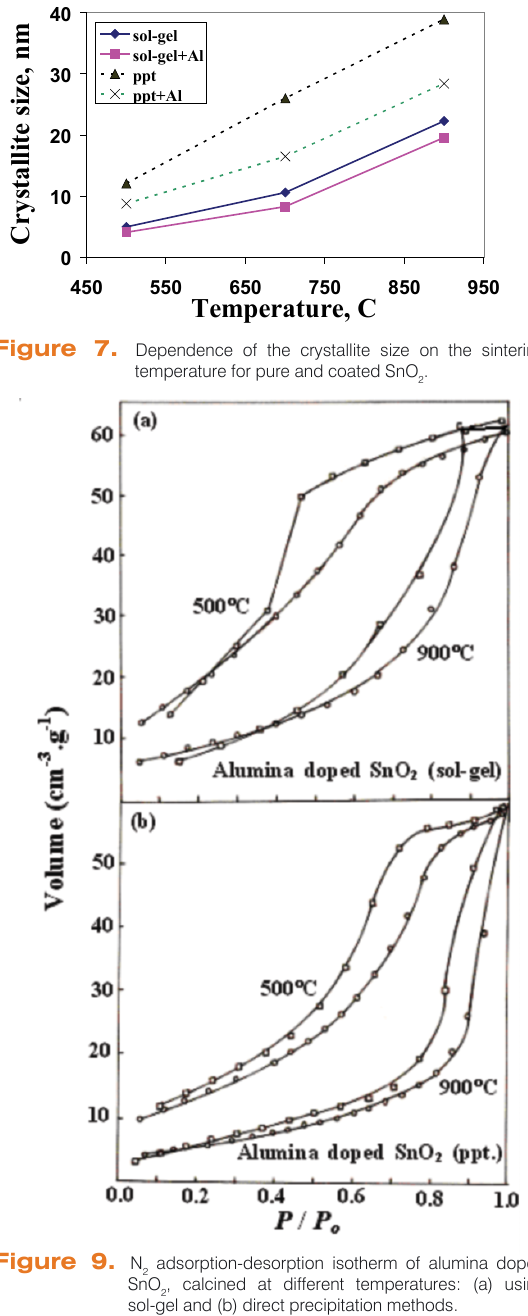
Figure 9. N adsorption-desorption isotherm of alumina doped 2 SnO , calcined at different temperatures: (a) using 2 sol-gel and (b) direct precipitation methods.